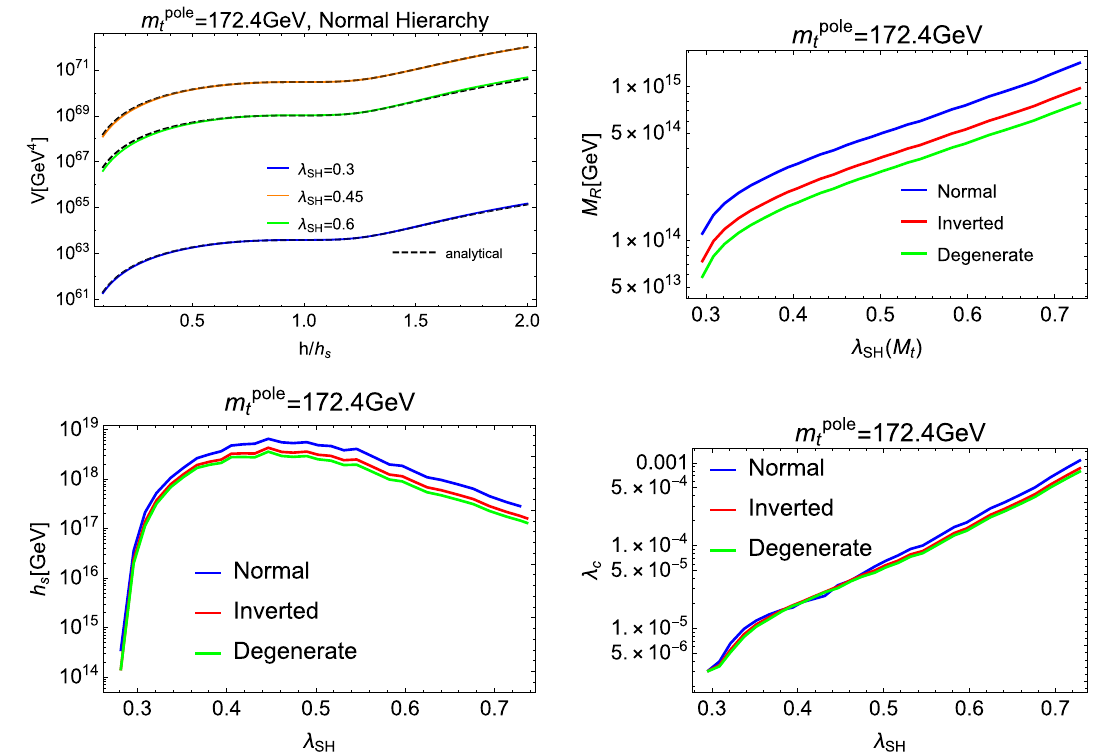
point condition (24). Lower Left: the saddle point h s as a function of λ ( M ) , where blue and red correspond to the normal and inverted SH t hierarchy, while green to degenerate. Lower Left: the minimum value of λ H as a function of λ SH ( M t